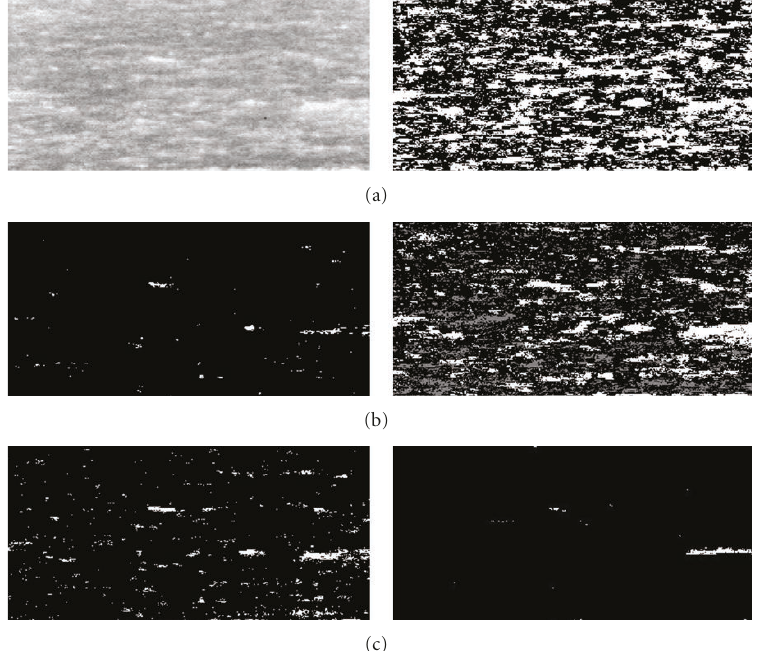
Figure 8: MW08 sequence in the 3–5 μ m band. From left to right, (a): original, mean.(b): gmm, EGMM, (c): ViBe, behaviour subtraction.